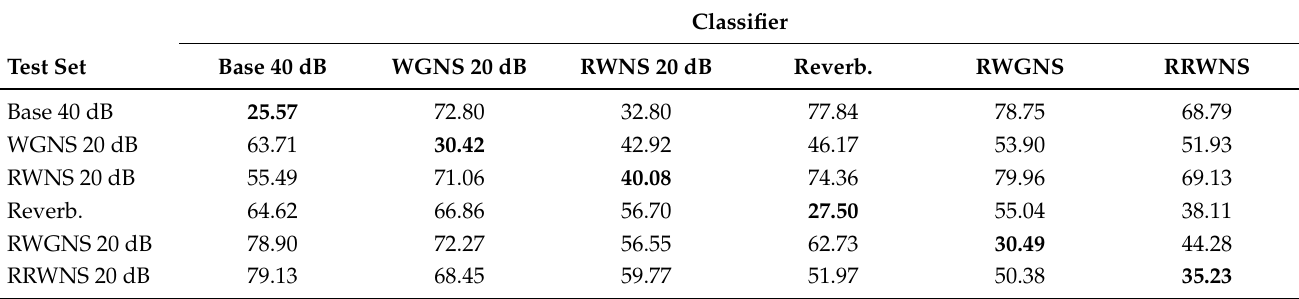
Table 3. First stage experiment results. Error probability (%) cross results within different noises